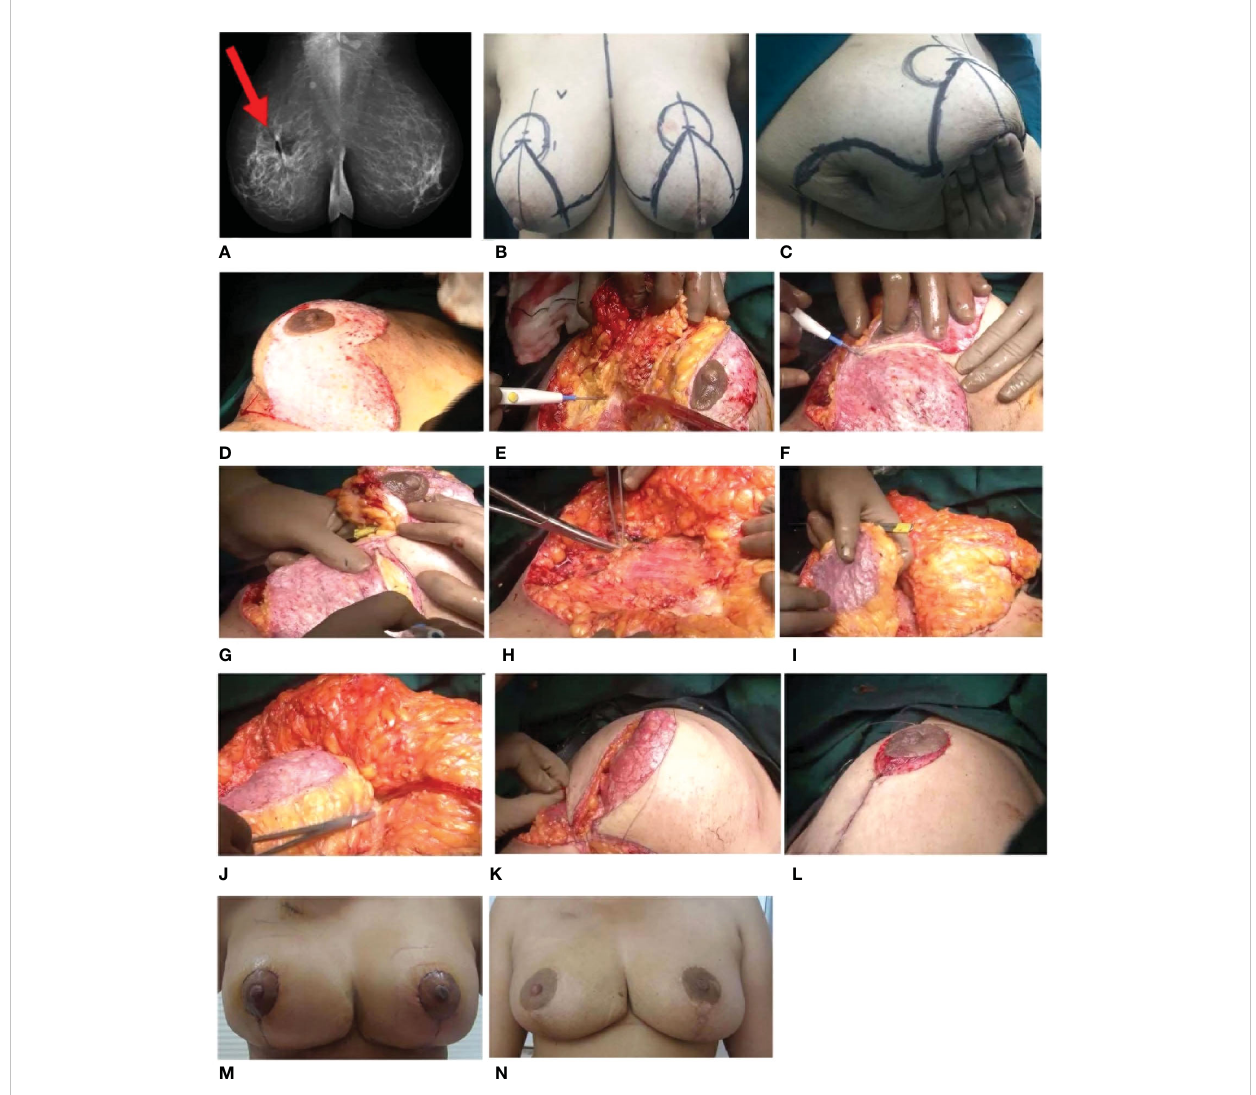
FIGURE 7 Extreme TM. (A) Pre-operative radiology imaging 2D mammogram — MLO view of both breasts. Ill-de fi ned spiculated lesion is seen in the upper deep central quadrant of the right breast, and single enlarged right axillary node is seen. (B) Markings. (C) Previous lumpectomy scar. (D – L) Intra-operative images. (D) De-epithelialization of the infero-medial pedicle. (E) Excision of the tumor with skin. (F) De fi ning the pedicles. (G) Nipple – areolar complex (NAC) is on the superomedial pedicle, and inferior pedicle is de fi ned to be used as a fi ller. (H) Clipping of the tumor bed. (I) Inferior pedicle used as a fi ller in the defect (arrow). (J) Inferior pedicle used as a fi ller and fi xed. (K) Restructuring of the breast. (L) Re-structured breast. (M, N) . Post-operative images. (M) One-month follow-up. (N) Annual follow-up. TM, therapeutic mammoplasty; MLO, mediolateral